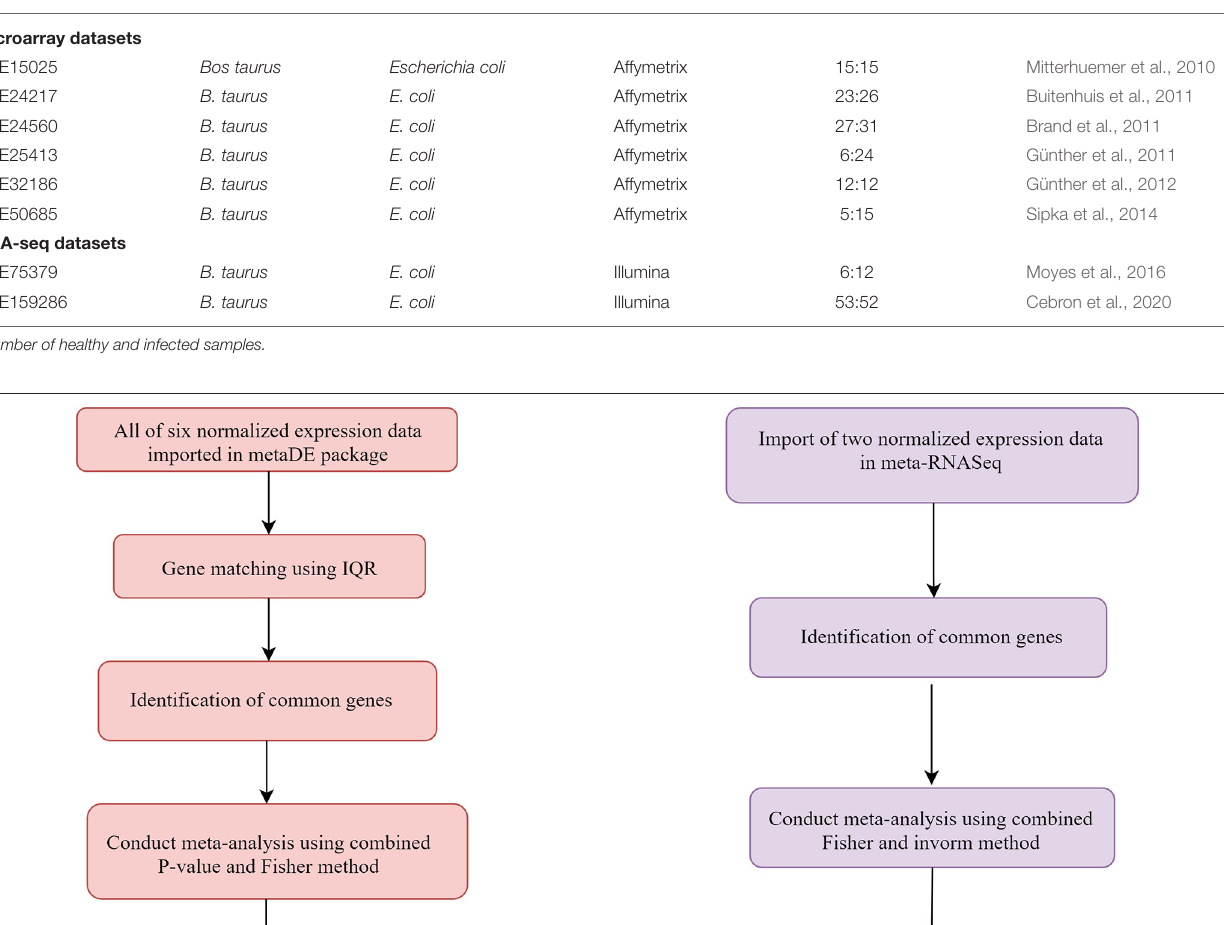
T = 24 h and T = 192 h after infection. In total, 12 heifers were intramuscularly vaccinated with heat-killed E. coli for the GSE159286 investigations. Half of the heifers (IM group, n = 6) received a booster injection 2 months later. Others (IMM group, n = 6) received 50 g of protein concentrate produced from